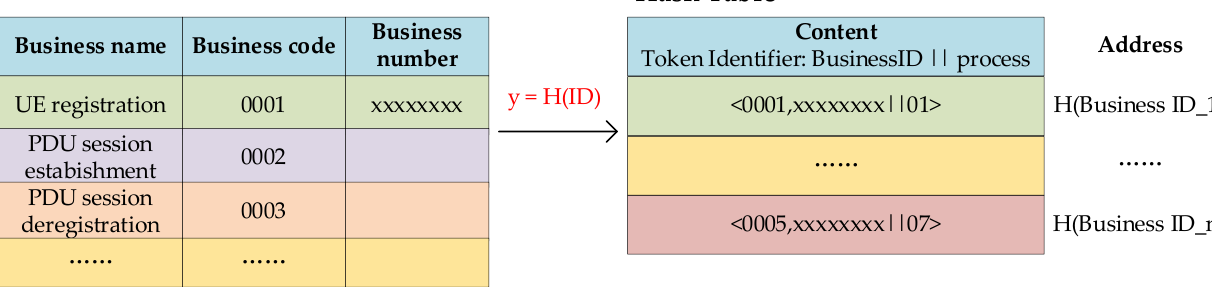
Figure 6. Storage of Token Identifiers in the